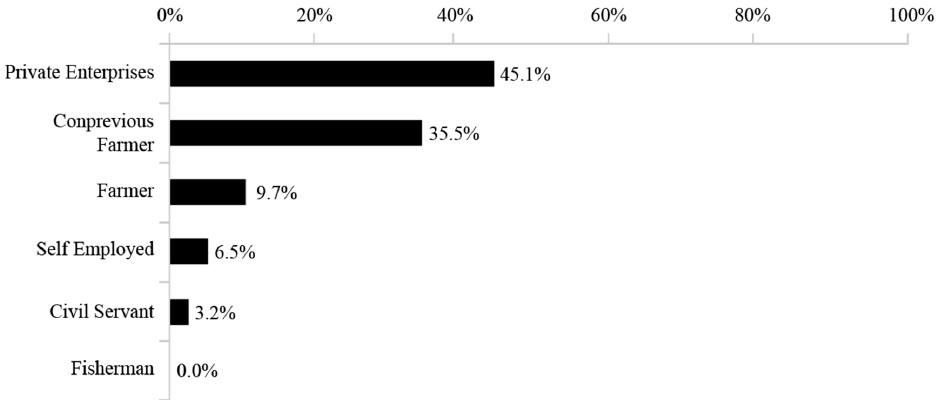
Figure 6. Occupations of targets (n = 31).